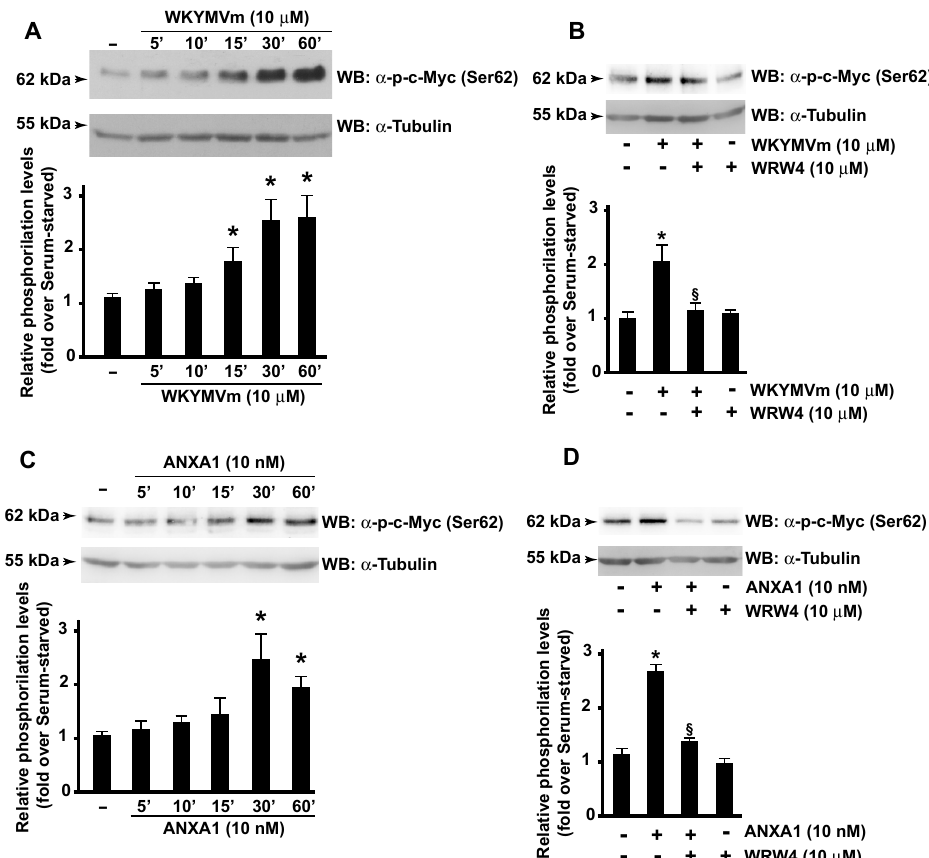
Figure 4. WKYMVm or ANXA1 stimulation triggers c-Myc phosphorylation. Growing CaLu-6 cells were serum-deprived for 24 h and then stimulated with WKYMVm (Panel A ) or ANXA1 (Panel C ) for the indicated times. Cells were also preincubated with WRW4 before the stimulation with WKYMVm (Panel B ) or ANXA1 (Panel D ). Sixty micrograms of whole lysates were resolved on 10% SDS-PAGE and incubated with an anti-phospho-c-Myc (Ser62) ( α -p-c-Myc (Ser62)) antibody. An anti-Tubulin ( α -Tubulin) antibody was used as a control for protein loading. Bar graphs are representative of three independent experiments. * p < 0.05 compared to unstimulated cells. § p < 0.05 compared to stimulated cells.